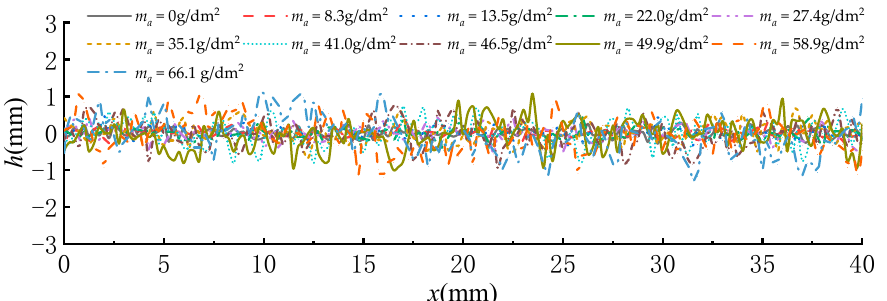
Figure 14. Randomly generated two-dimensional contour curves under different corrosion degree.